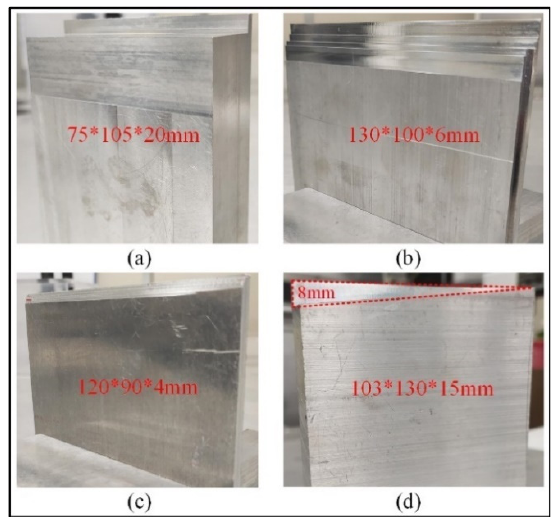
Figure 4. Workpiece with different shapes. ( a ) Shape #1; ( b ) Shape #2; ( c ) Shape #3; ( d ) Shape #4.